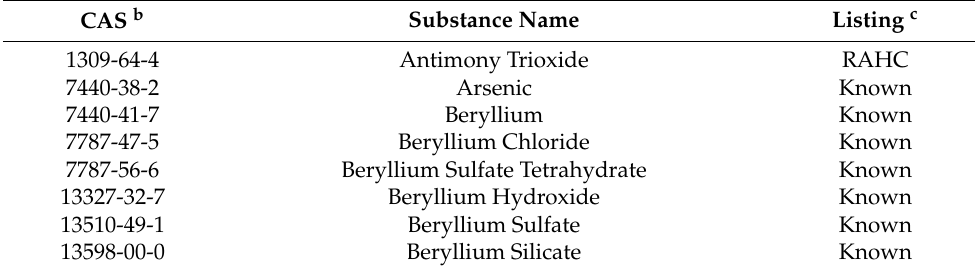
Table A1. Critical Element forms listed in the 15th Report on Carcinogens, 2021 a